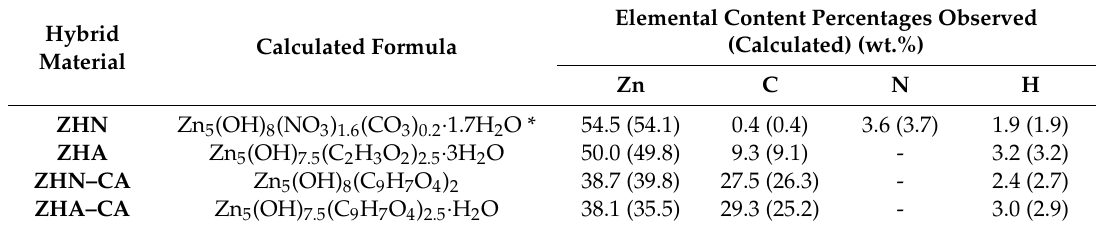
Table 1. Chemical composition and calculated formula of the hybrid materials. Hybrid Material